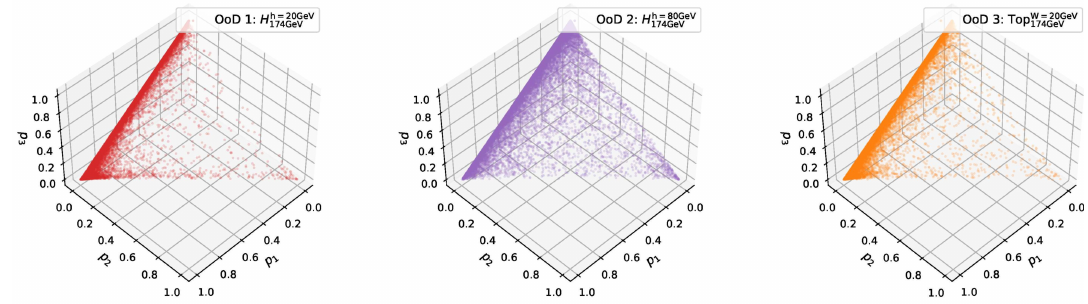
Figure 2 . Softmax simplices of out-of-distribution classes within a QCD/W/Top classifier. ( { p k } 3 denotes the corresponding softmax probabilities in classes of QCD, W, and Top.)